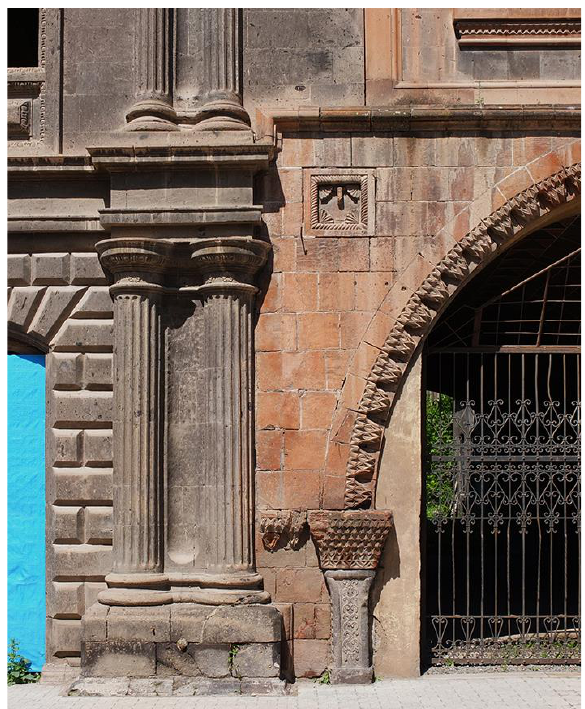
Figure 11. Fragment of Gyumri’s vernacular ensemble: stylistic collage on Abovyan Street. Photo by the author, 2017.